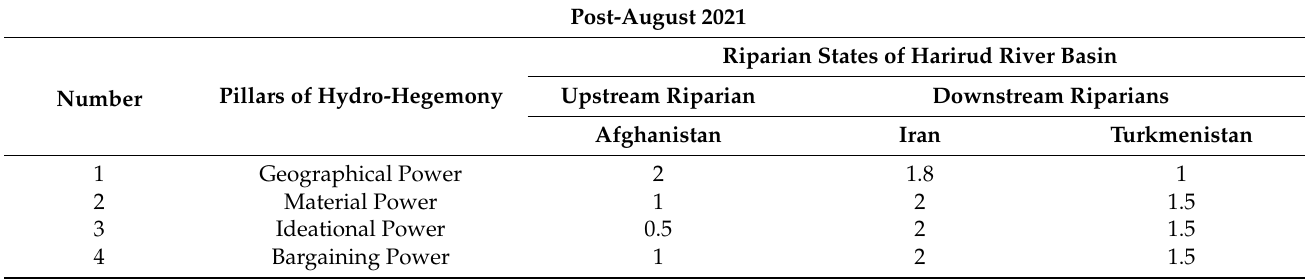
Table 2. The fluctuation of power in each pillar of hydro-hegemony after Taliban’s taking